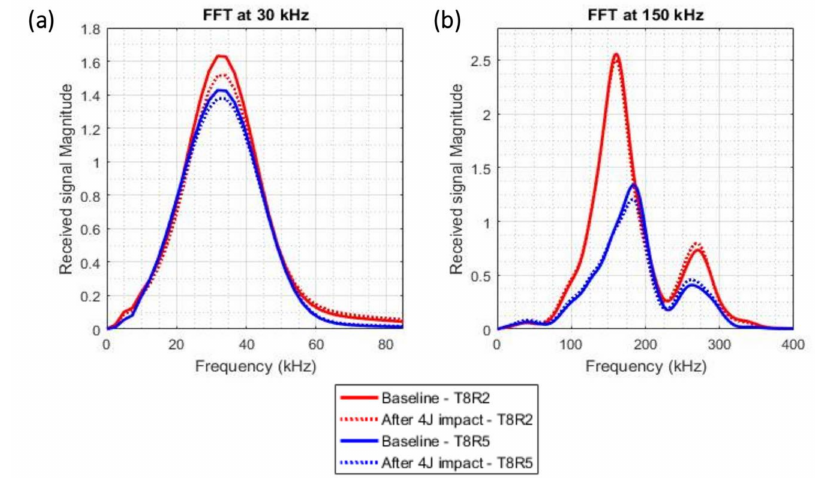
Figure 9. Comparison of FFTs of signals generated at ( a ) 30 kHz and ( b ) 150 kHz from transmitter ‘T8’ and received by receivers ‘R2’ (path on skin—in red) and ‘R5’ (path on web—in blue), for the baseline and for signals acquired after a 4J impact in the middle of the T-joint.